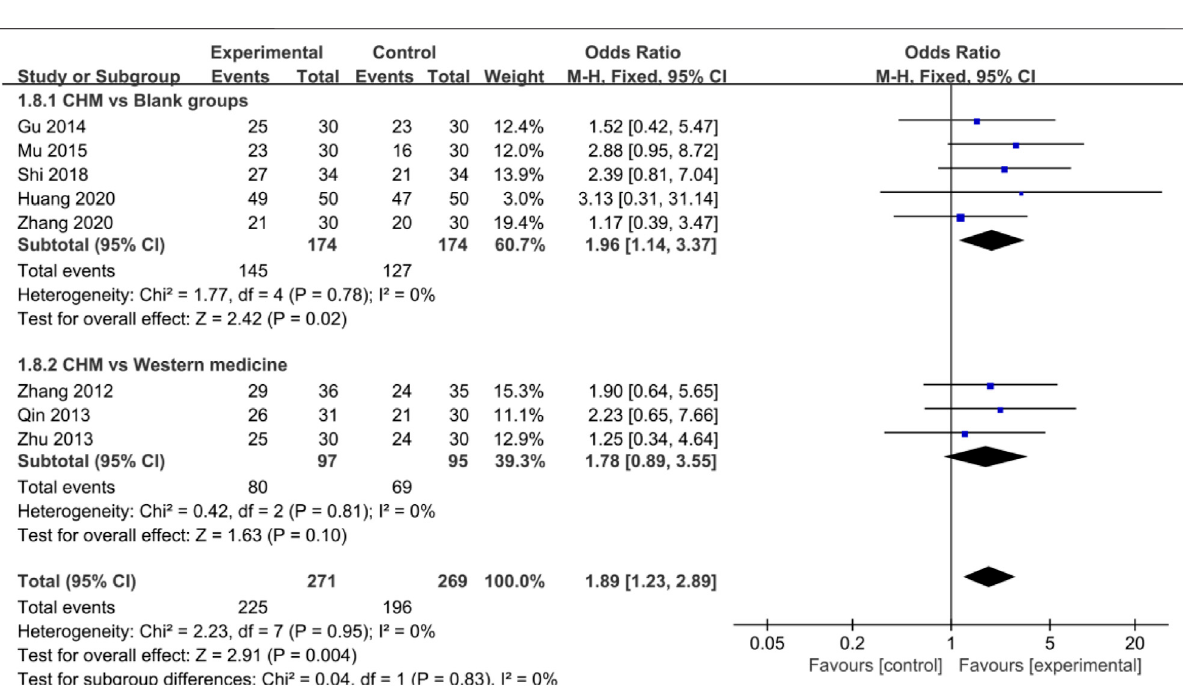
Frontiers in Pharmacology |